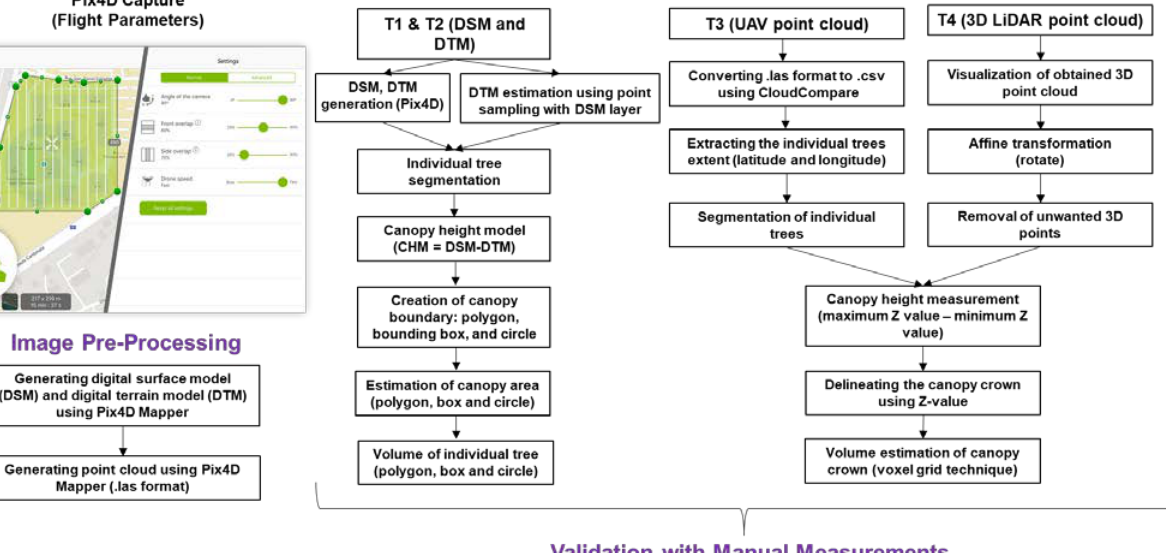
Figure 2. The methodology utilized in this study to extract the canopy architectural traits from the individual trees using UAV and LiDAR